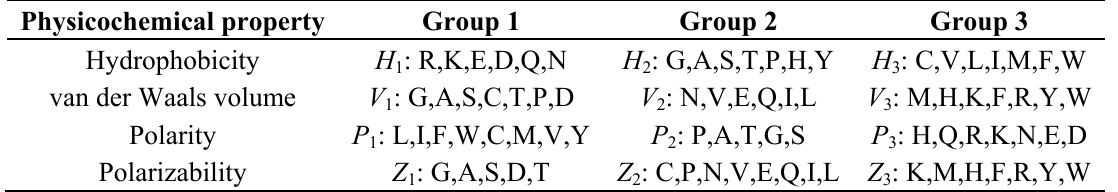
Table 6. Amino acid groups classified according to their physicochemical value. Physicochemical property Group 1 Group 2 Group 3